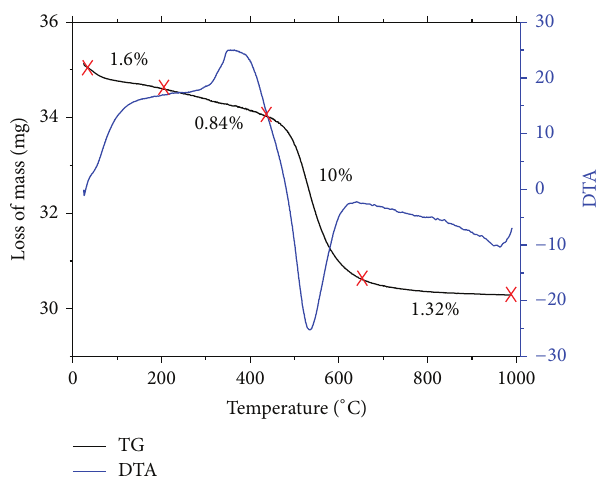
Figure1:Thermogravimetricanddifferentialthermalanalysisofthe mass before the